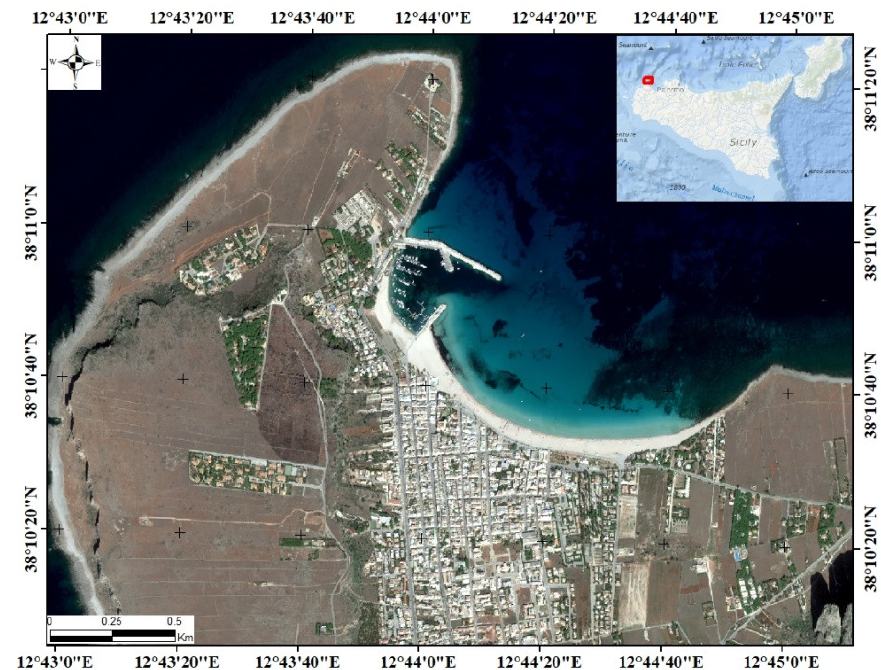
Figure 1. Map, indicating the location of the coast of the San Vito Lo Capo peninsula. Note the presence of large sand beach, harbor, and the city of San Vito Lo Capo ( © GeoEye-1 satellite image acquired on 18 October 2014).